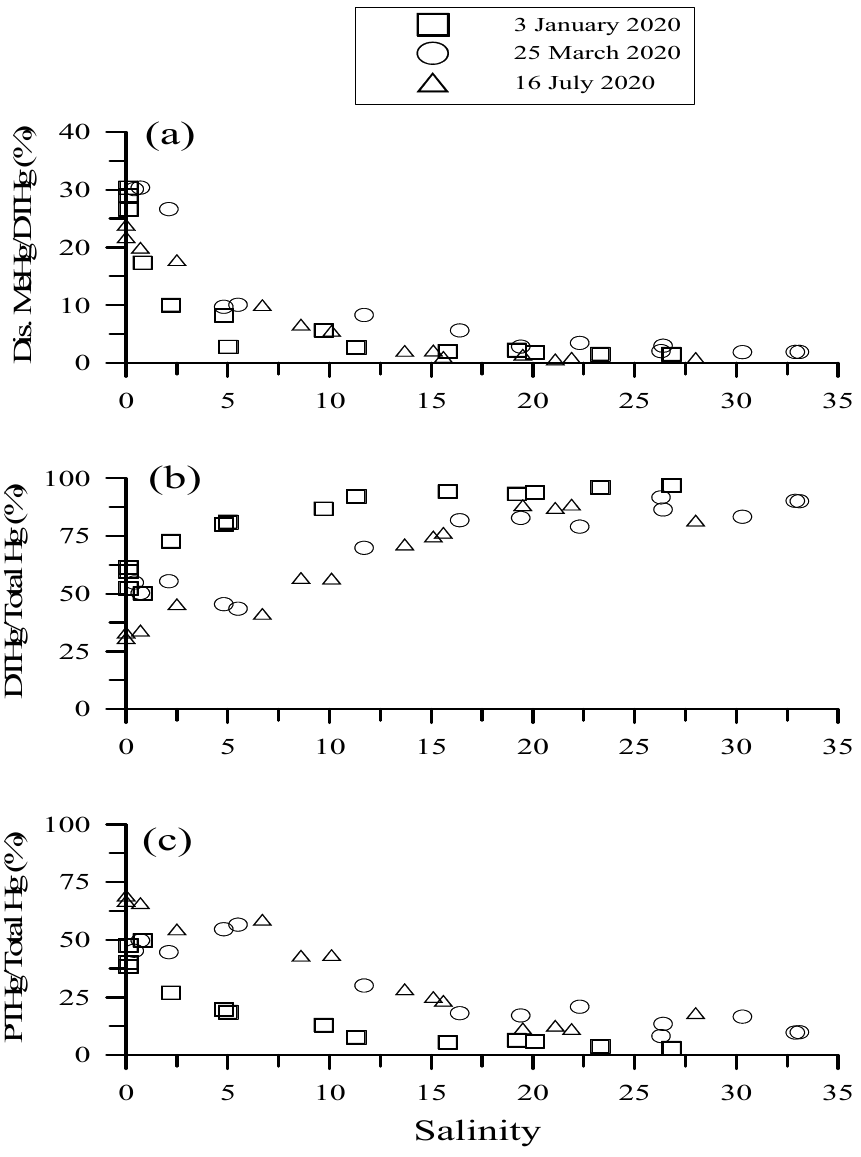
Figure 5. Percentage of ( a ) DMeHg/DTHg, ( b ) DTHg/THg, and ( c ) PTHg/THg against salinity in the Danshuei River Estuary, northern Taiwan.